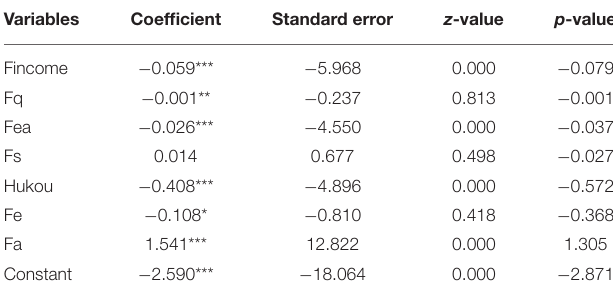
TABLE 4 | Balance test results of matching